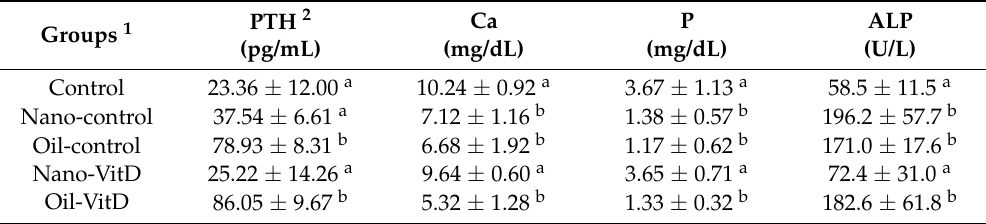
Table 2. Concentration of several blood biomarkers of VitD deficiency in rats after one week of dietary